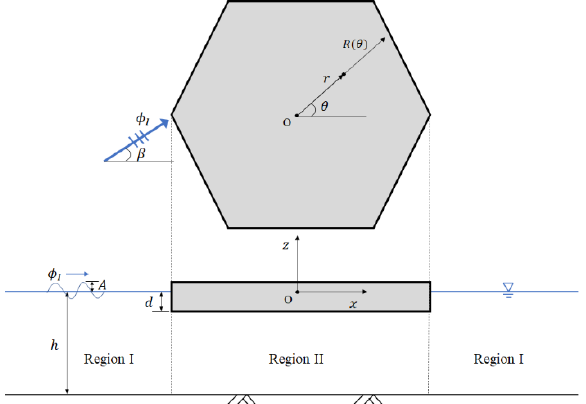
Figure 1. Floating polygonal platform under wave action.